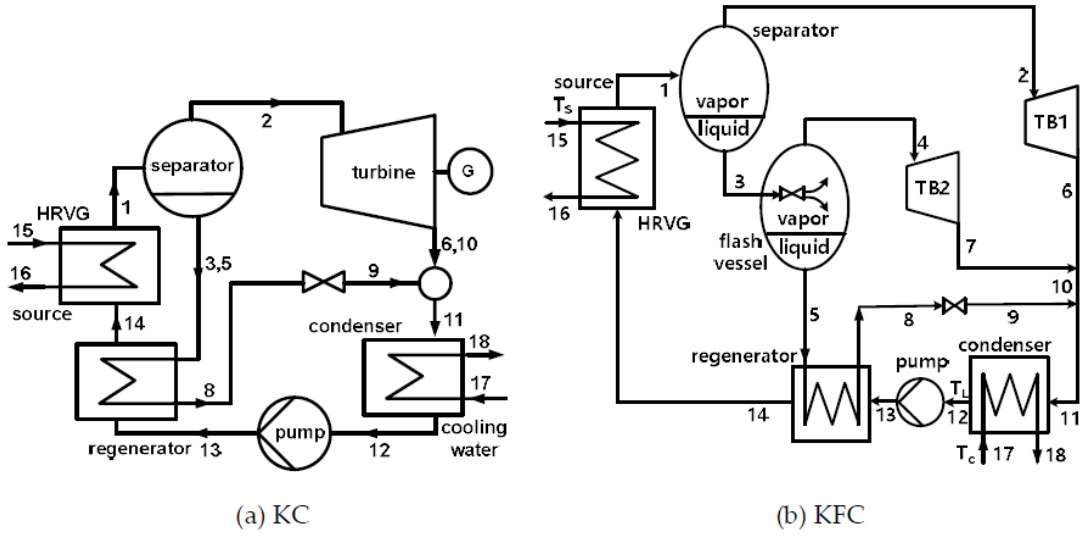
Figure 1. Schematic diagrams of the Kalina cycle ( a ) and the Kalina flash cycle ( b ).